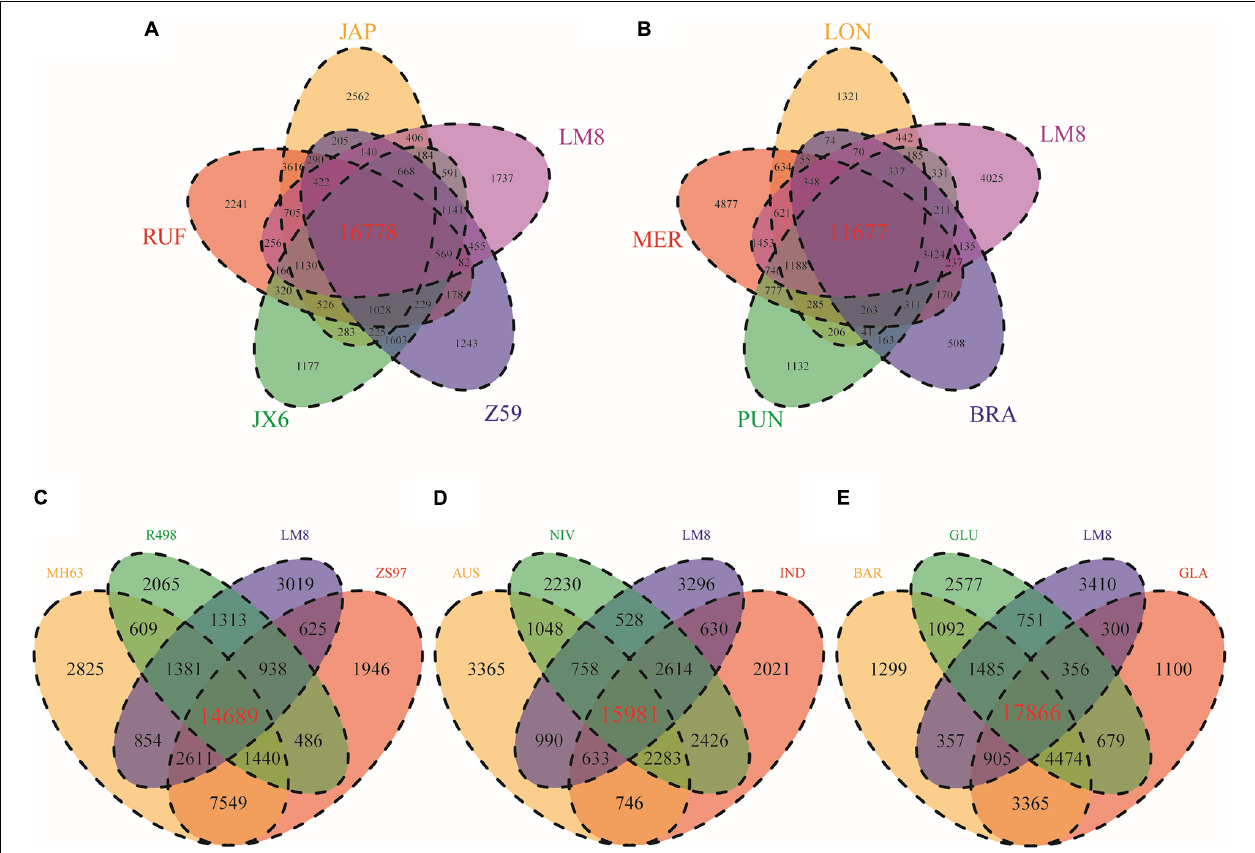
FIGURE 7 | Venn diagrams showing specific and shared gene families between LM8 and other Oryza genomes in the same cluster of the evolution tree. (A) JAP, RUF, JX6, Z59 and LM8. (B) LON, MER, PUN, BRA and LM8. (C) MH63, R498, ZS97 and LM8. (D) AUS, NIV, IND and LM8. (E) BAR, GLU, GLA, and LM8. AUS, O. aus . IND, O. sativa ssp. indica . JAP, O. sativa ssp. japonica . GLA, O. glaberrima . BAR, O. barthii . GLU, O. glumaepatula . MER, O. meridionalis . RUF, O. rufipogon . NIV, O. nivara . LON, O. longistaminata . PUN, O. punctata . BRA, O. brachyantha . JX-6, O. rufipogon var. JX-6. Z59, O. rufipogon var. Z59. MH63, O. sativa ssp. indica var. Minghui63. ZS97, O. sativa ssp. indica var. Zhenshan97. R498, O. sativa ssp. indica var. Shuihui498. and LM8, O. sativa f. spontanea